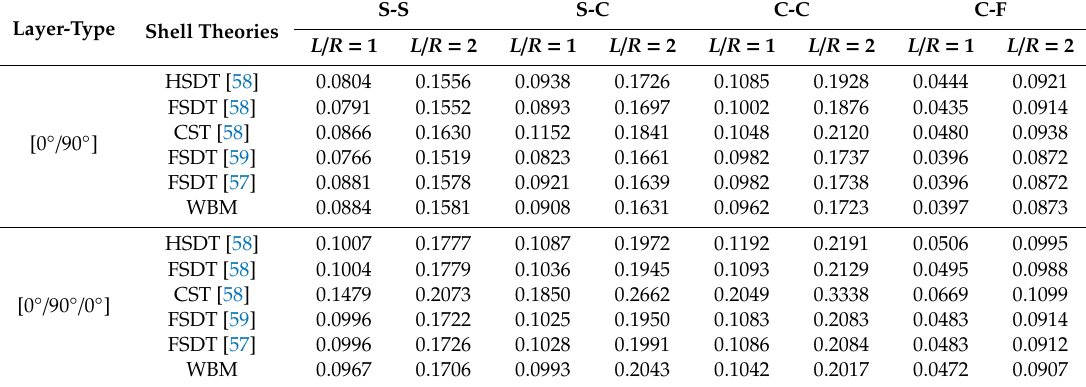
(cid:112) ρ Table 2. Frequency parameters Ω = ω L 2 / E 2 /100 h for two types of cross-ply composite laminated cylindrical shell with di ff erent length to radius ratios and boundary conditions ( R = 1 m, h / R =